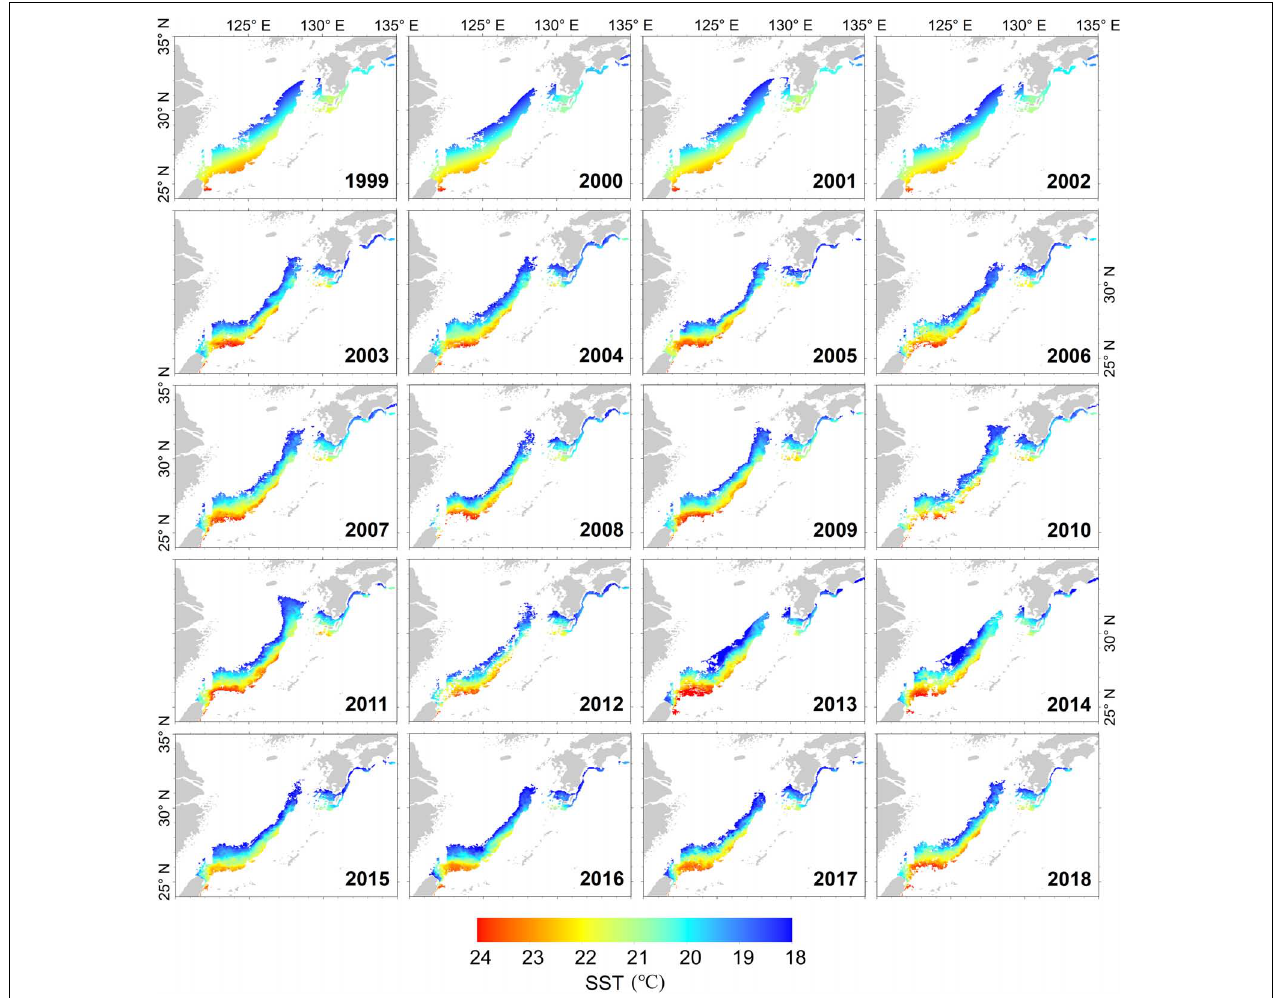
FIGURE 5 | The annual dynamic potential spawning ground of winter cohort of Japanese flying squid from 1999 to